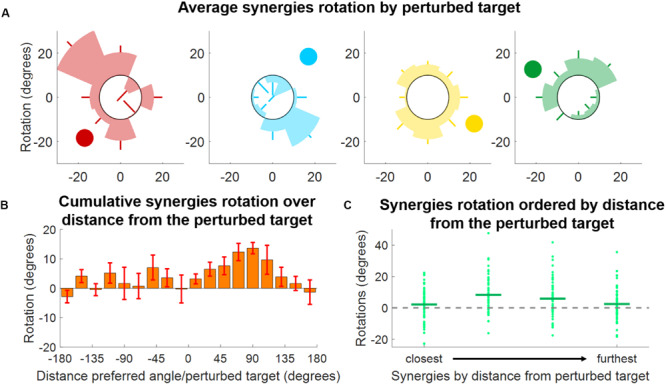
Synergies rotations for Experiment 2. (A) Average (across subjects) rotation for each synergy (color-coded) and for each perturbed target. Each shaded segment of each polar plot represents the average rotation relative to a perturbed target, while the lines represent the standard deviation. The darker circle represents the direction of the preferred angle for each synergy at BL. (B) Distribution of average (across subjects, targets, and synergies) synergy rotation values as a function of the distance between the synergy preferred angle and the perturbed target. Bars represent averages, whiskers standard deviations. (C) Synergies rotations for each macro-block after ordering the synergies from the closest to the perturbed target to the furthest. Individual dots represent the rotation of each single synergy (56 total dots, 8 targets times 7 subjects). Horizontal lines represent the median across all the individual values.